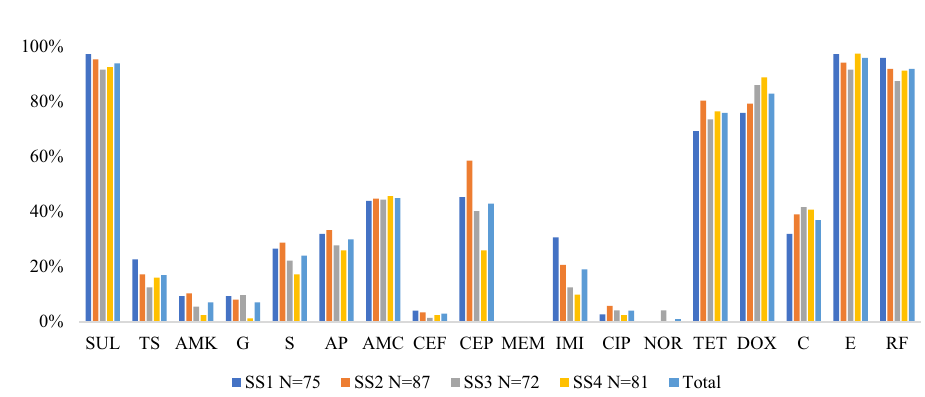
Figure 3. Antibiotic resistance profile of Vibrio isolates across the selected sampling sites. CIP ciprofloxacin, AMK amikacin, MEM meropenem, E erythromycin, AMC amoxicillin, IMP imipenem, TS trimethoprim–